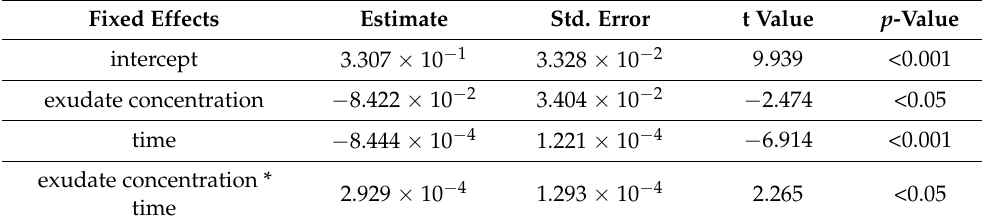
Table 1. Results of the linear mixed model on M. galloprovincialis clearance rates (Lh −1 ) exposed to A. armata exudate over time. Significant at p < 0.05 and p < 0.001. “exudate concentration * time” term represents the interaction between these two fixed effects.